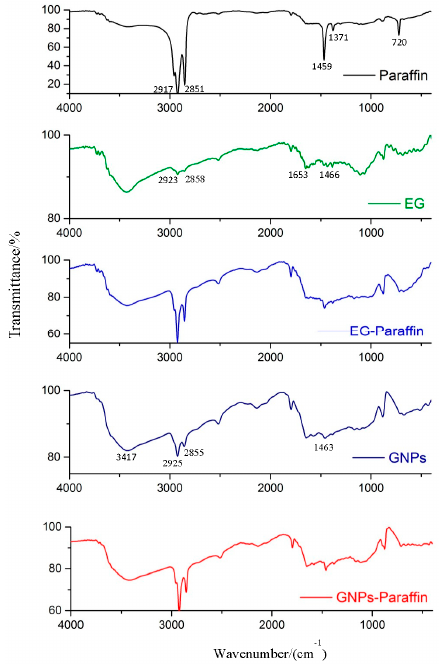
Figure 5. FT-IR spectra of paraffin, EG, GNPs, EG–paraffin, GNP–paraffin.